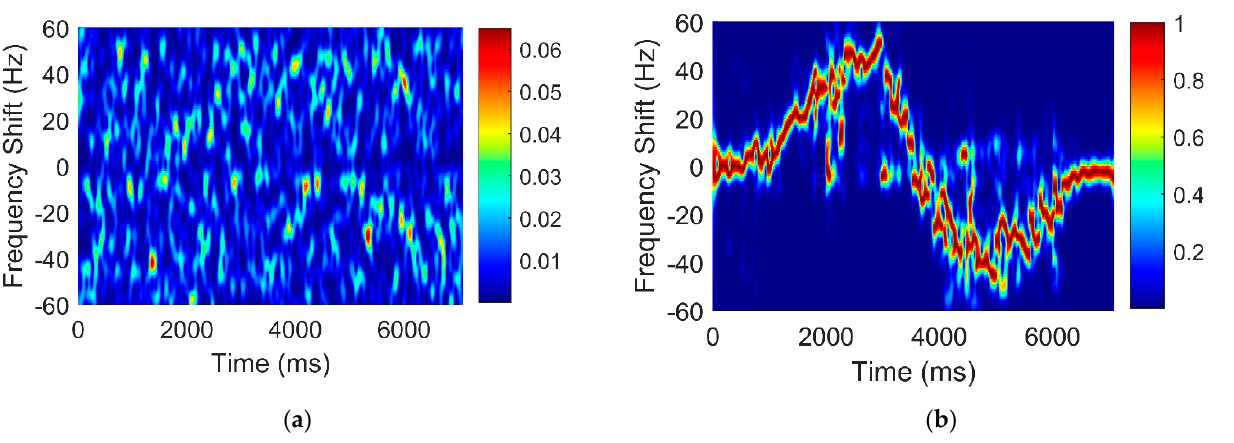
Figure 3. ( a ) Measured time-frequency chart without static elimination; ( b ) Measured time-frequency chart with static elimination.